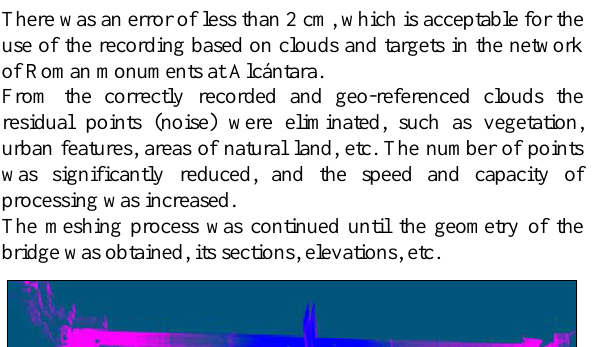
Table 1. Comparison of laser and topographic points.